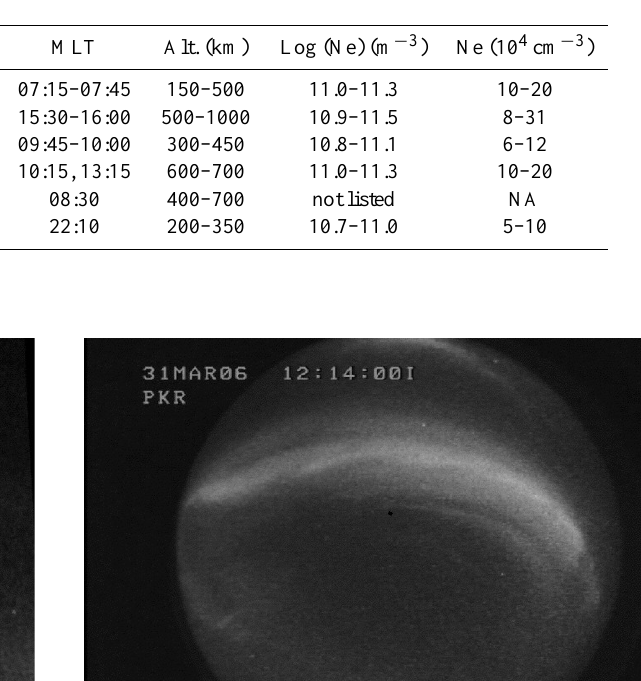
Table 1. Summary of the altitudes and densities associated with NEIAL studies. The overall range of densities typically measured is 1 to 100 × 10 4 cm − 3 .